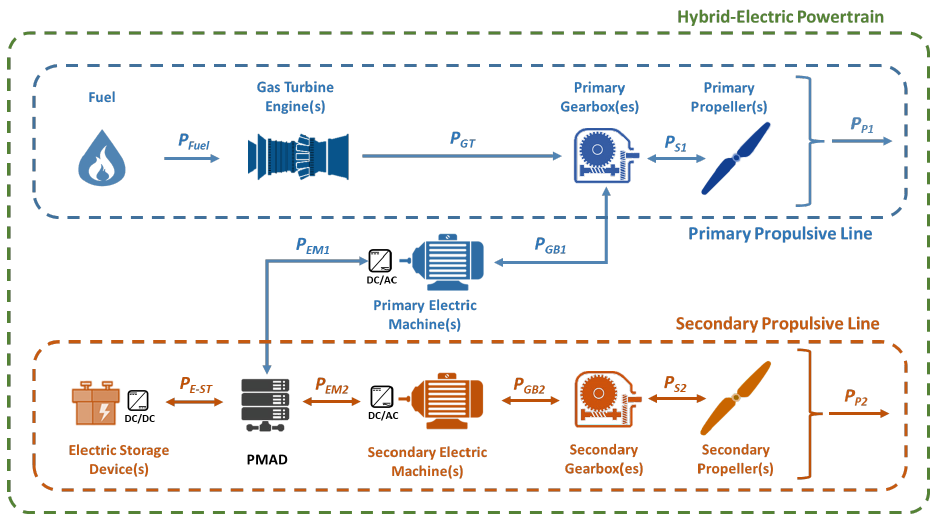
Figure 1. Example of a hybrid-electric propulsive scheme based on gas turbine engines and electric storage devices.